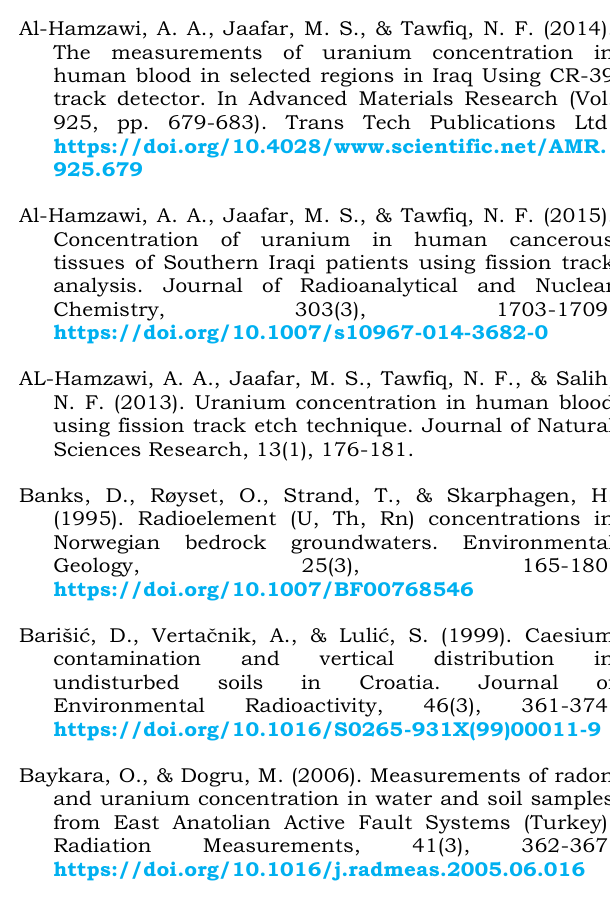
depicts the overall average uranium concentration in southern Basrah governorate soil samples as a function of location. The maximum uranium content in soil samples was 2.67 ppm, which was detected in Al Shuaiba Center. This result is lower than the uranium concentration safety threshold of 2.8 ppm. This outcome can be linked to the fact that during the Gulf war, this region was heavily bombarded with uranium weapons.